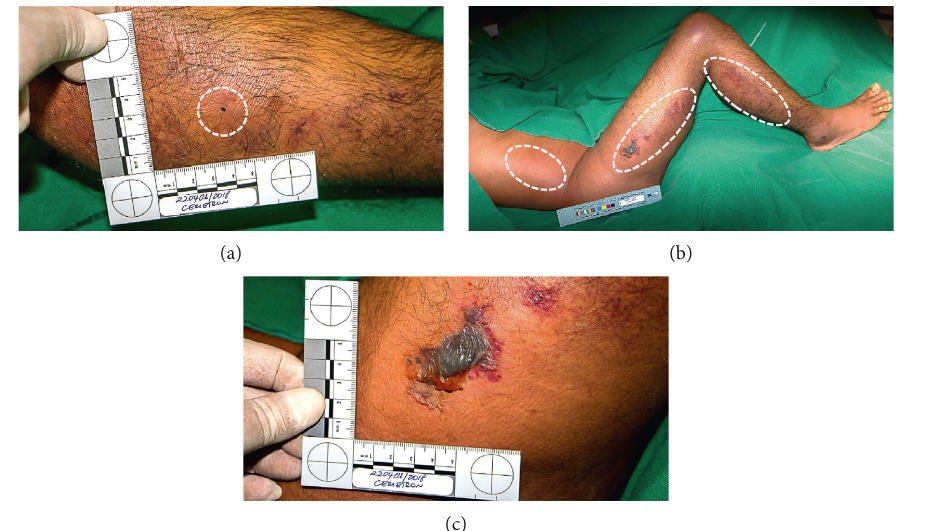
Figure 1: Bothrops jararaca (family Viperidae) snakebite on the right leg. (a) Venom entrance. (b, c) Swelling, blistering, and